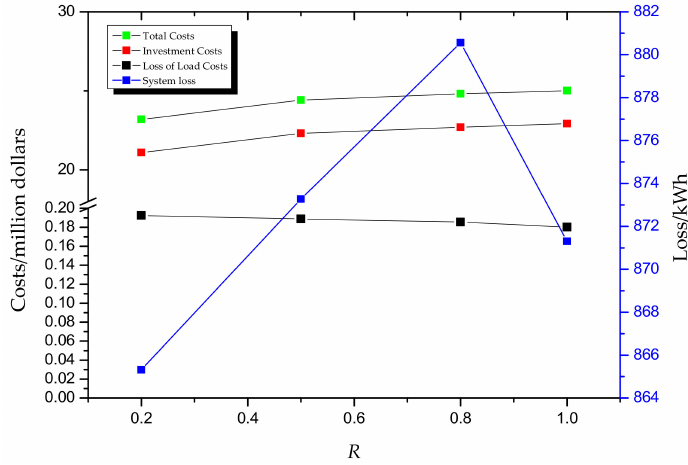
Figure 6. Trend analysis of the distributed power planning economic scenario in Case